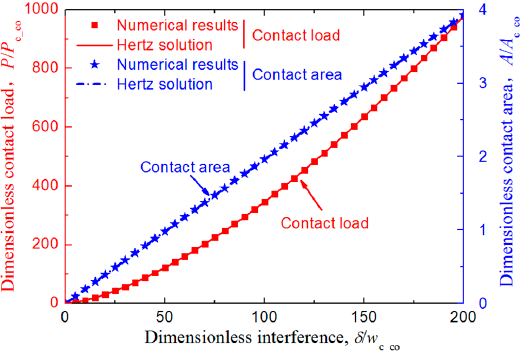
Figure 3. Comparison of the dimensionless contact parameters (including contact load, P / P c_co , and area, A / A c_co ) between the Hertz results and the FE model developed in this work considering the purely elastic material cases when the two asperities were aligned vertically with respect to the axes of symmetry of Asperity 2 ( X = 0) without sliding.